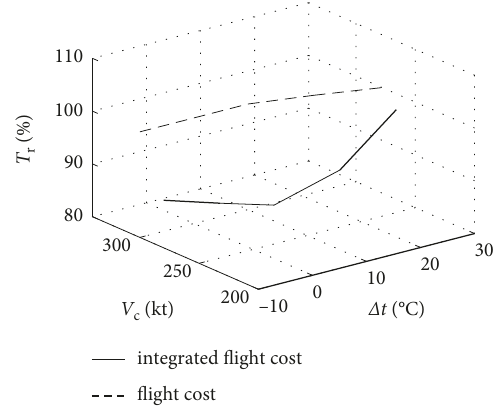
Figure 7: Effect of temperature on optimization parameters.